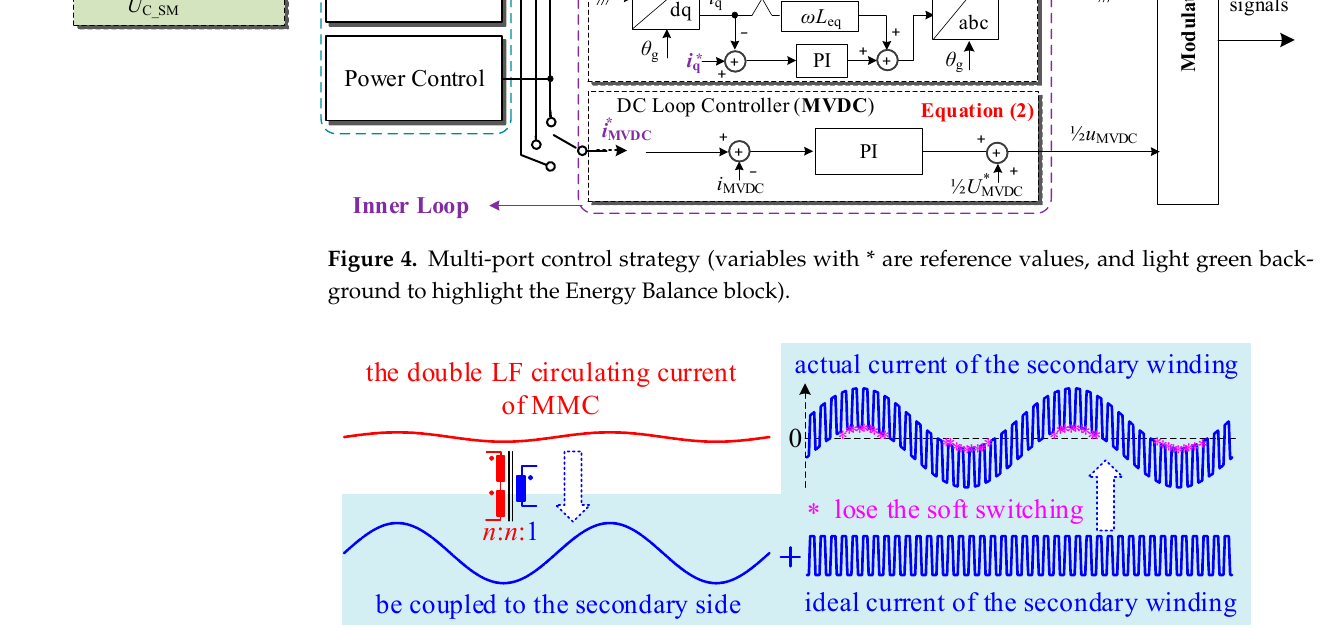
Figure 5. Effects of MMC circulating current on the LVDC side.